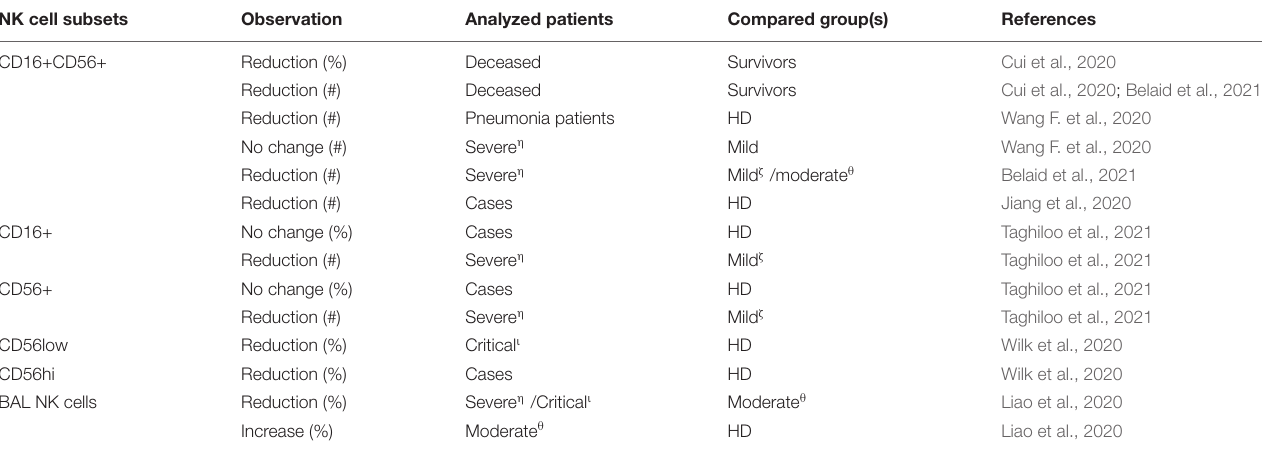
TABLE 1 | Observed fluctuation in NK cells in adult COVID-19